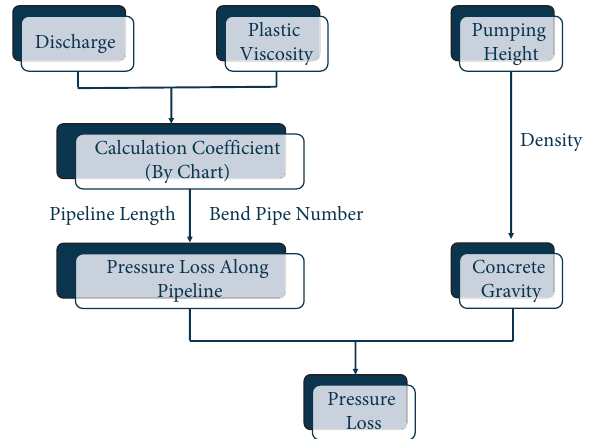
Figure 12: The simplified pressure loss calculation method for the concrete